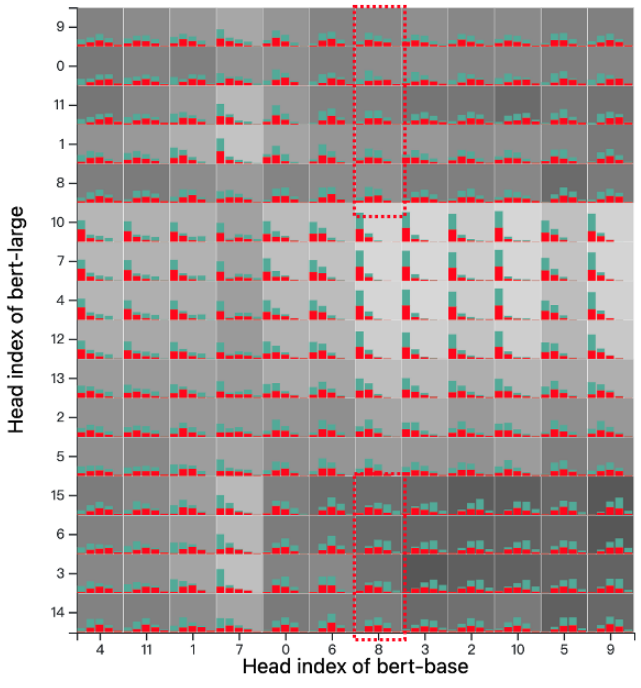
Figure 20. The user checks the heads of bert-large which is similar to the eighth head of bert-base.